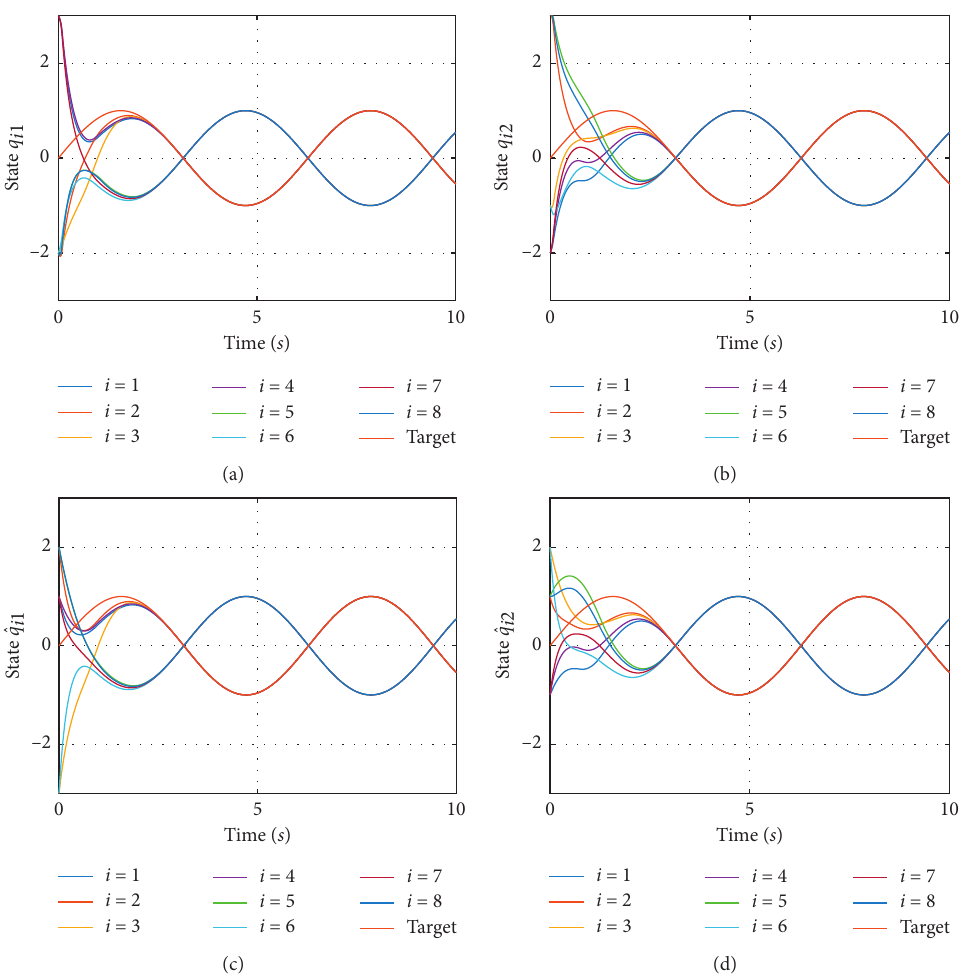
􏽢 q i for links 1